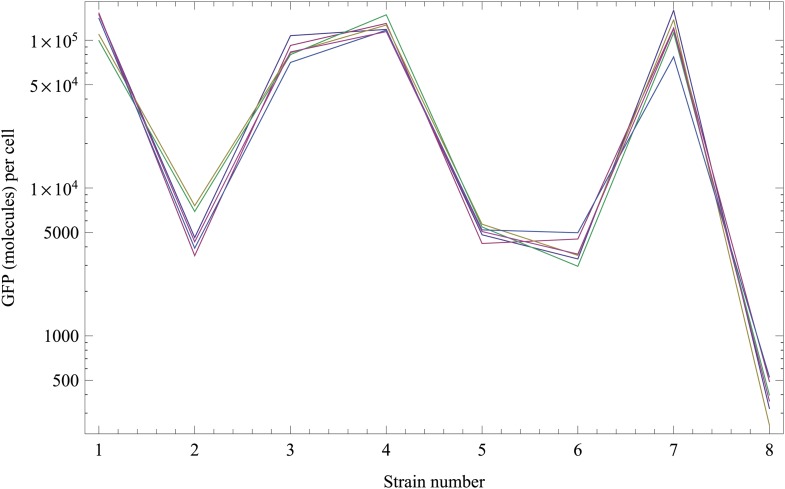
Normalized inferred GFP amounts (molecules per cell, vertical axis) for the eight strains (strain numbers shown along the horizontal axis) using the reference data from each replicate.Each color corresponds to a replicate. The vertical axis is shown on a logarithmic scale.